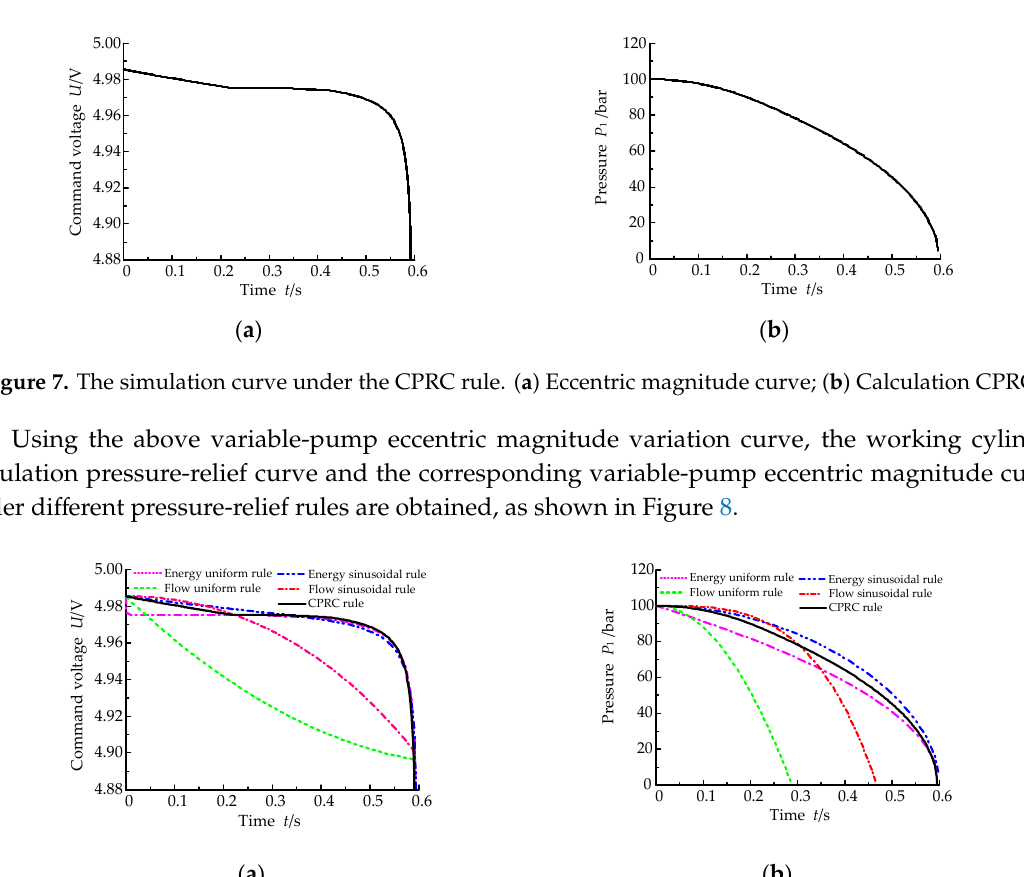
Figure 8. The simulation curve under the different pressure-relief rules under initial pressures of 100 bar. ( a ) Eccentric magnitude curves; ( b ) Calculation of CPRC. 5.2. Pressure-Relief Impact Control Under the above pressure-relief rules, the initial pressure of 150 bar was used as the research condition to generate the working cylinder simulation pressure-relief curve and the corresponding variable-pump eccentric magnitude curve under different pressure-relief rules, as shown in Figure 9. Figures 8 and 9 show that in the pressure-relief initial pressure, when the storage energy of the working cylinder changes in accordance with flow uniform rule, flow sinusoidal rule, energy uniform rule, CPRC rule, and energy sinusoidal rule in turn, the working cylinder pressure-relief time increases, but it is controlled in the 0.6 s pressure-relief cycle. With the same pressure-relief curve and different initial pressures, as the pressure-relief initial pressure increases, the energy stored in the working cylinder and the pipeline increases, resulting in an increased pressure-relief gradient. Under the above pressure-relief rules, the pressure-relief characteristics of the OCPFHS were obtained under the pressure-relief initial pressure of 100 bar and 150 bar, respectively, as shown in Figure 10. Figure 10 shows that under the same pressure-relief initial pressure, when the storage energy of the working cylinder changes in accordance with the energy uniform rule, energy sinusoidal rule, flow uniform rule, flow sinusoidal rule, and CPRC rule in turn, the pressure fluctuations of the relief pipe under the above pressure-relief rules is obviously lower than that of the step pressure-relief rule. In addition, the pressure fluctuation peak value and frequency of the relief pipe decrease in turn and are obviously lower than other rules. With the same pressure-relief curve and different initial